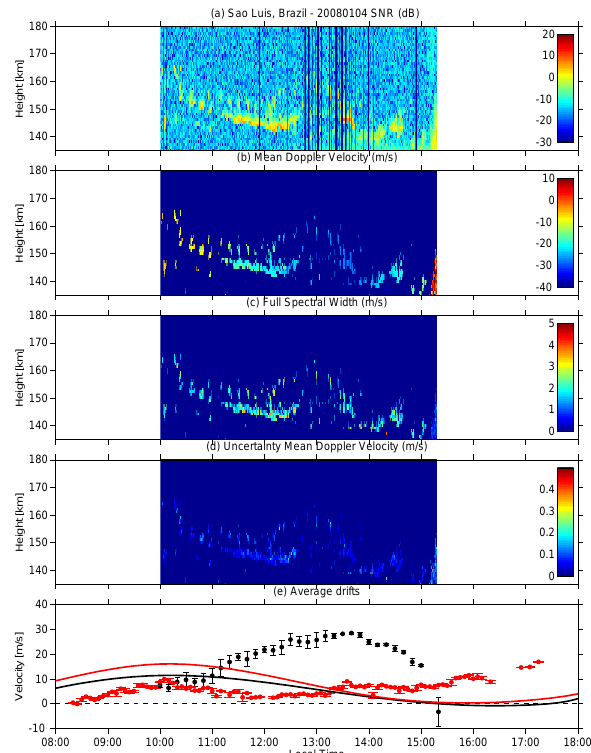
Fig. 3. Same as Fig. 2 but for 4 January 2008. The mean Doppler